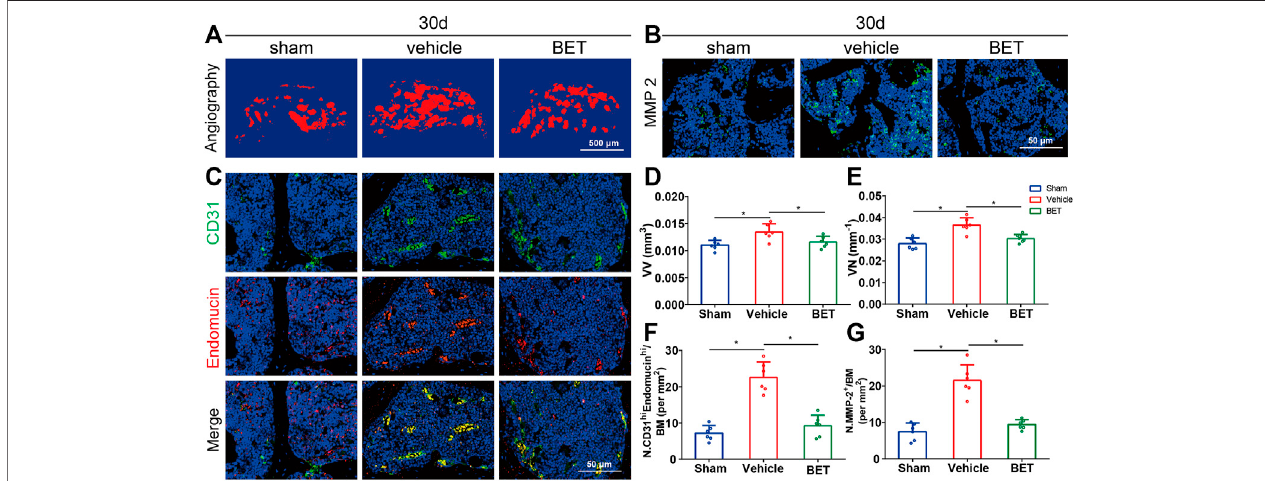
FIGURE 6 | Betaine inhibits aberrant vessel formation in ACLT mice. (A) 3D microangiography of medial compartment of tibial subchondral bone 30 days post operation. Scale bar, 500 μ m. (B) Representative immuno fl uorescence staining of MMP-2 in ACLT mice 30 days after operation. Scale bar, 50 μ m. (C) Representative double staining of CD31 positive and Endomucin positive cells 30 days post operation. Scale bar, 50 μ m. (D) Quantitative analysis of vessel volume relative to tissue volume (VV/TV). (E) Quantitative analysis of vessel number (VN). (F) Quanti fi cation of CD31 positive and Endomucin positive cells 30 days post operation. (G) Quantitative analysis of MMP-2 positive cells 1-month post operation. * p < 0.05 as denoted by bar, ** p < 0.01 as denoted by